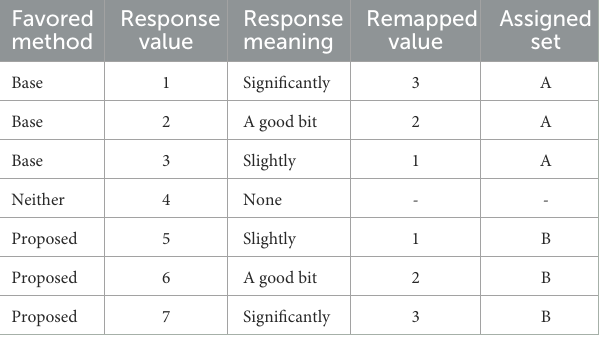
TABLE 3 Re-mapping of responses obtained from the